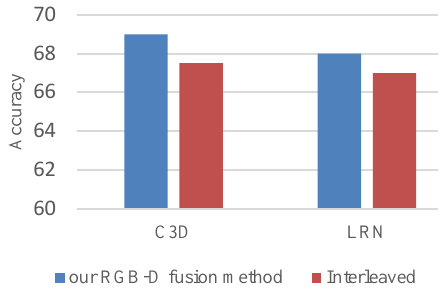
Figure 6 comparing our early fusion method vs. interleaved RGB-D fusion introduced in [20].